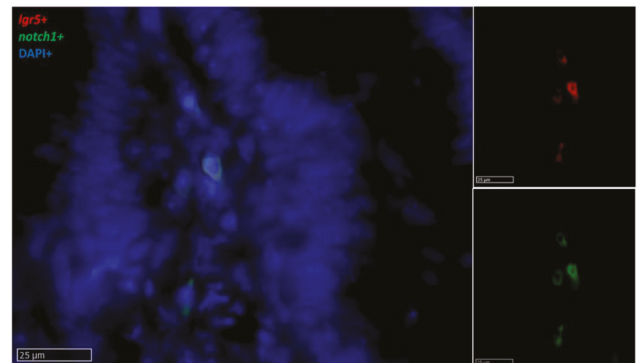
Figure 14. In situ hybridization of lgr5 (red dots) and notch1 mRNA (green dots) in the basal part of the complex folds of the second segment of the mid-intestine. Both genes were expressed by a few stromal cells in the fold axis.